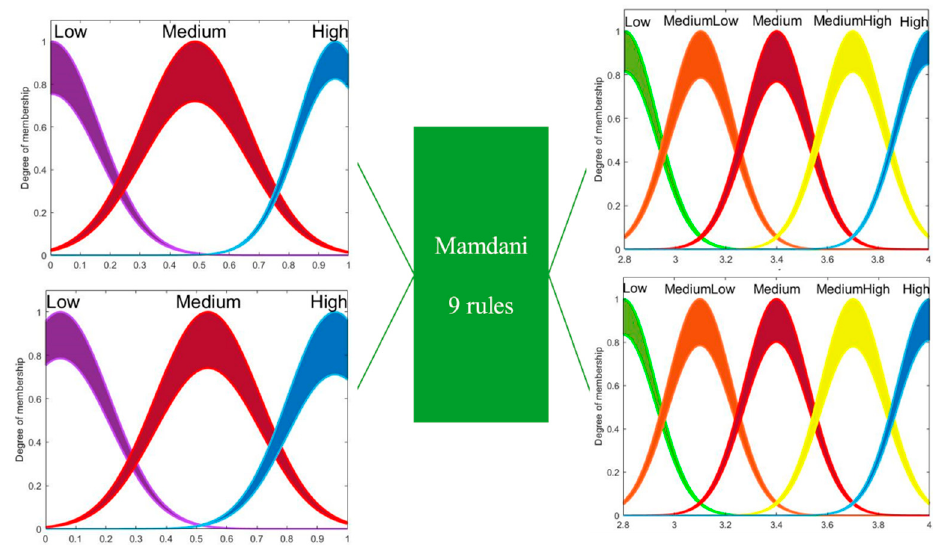
Figure 10. IT2FS proposed for the parameter dynamic adaptation using Gaussian MFs.